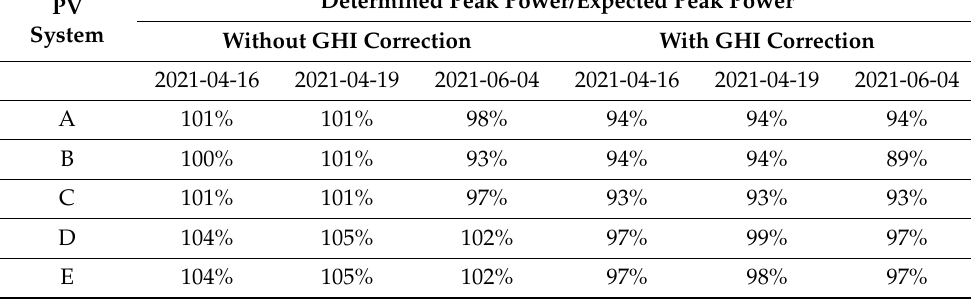
Table 2. Determined peak power divided by the expected peak power of the five PV systems for three sunny days each. The expected peak power was taken as the nominal peak power that was reduced by the maximal nominal degradation over time from installation to the measurement; 100% means that the system runs as expected if the maximal allowed degradation has happened. Weather data was taken from the stations named in Section